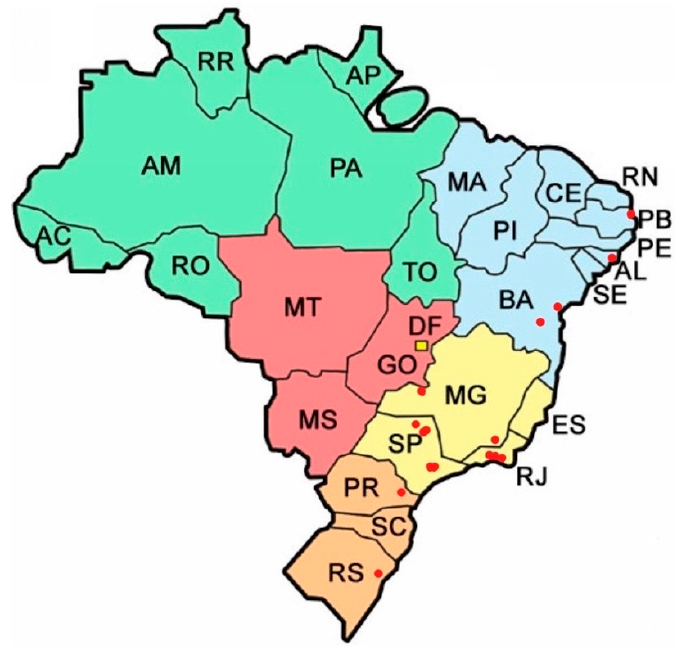
Figure 1. Federative units with higher education institutions that house research groups in Spirituality and Health.